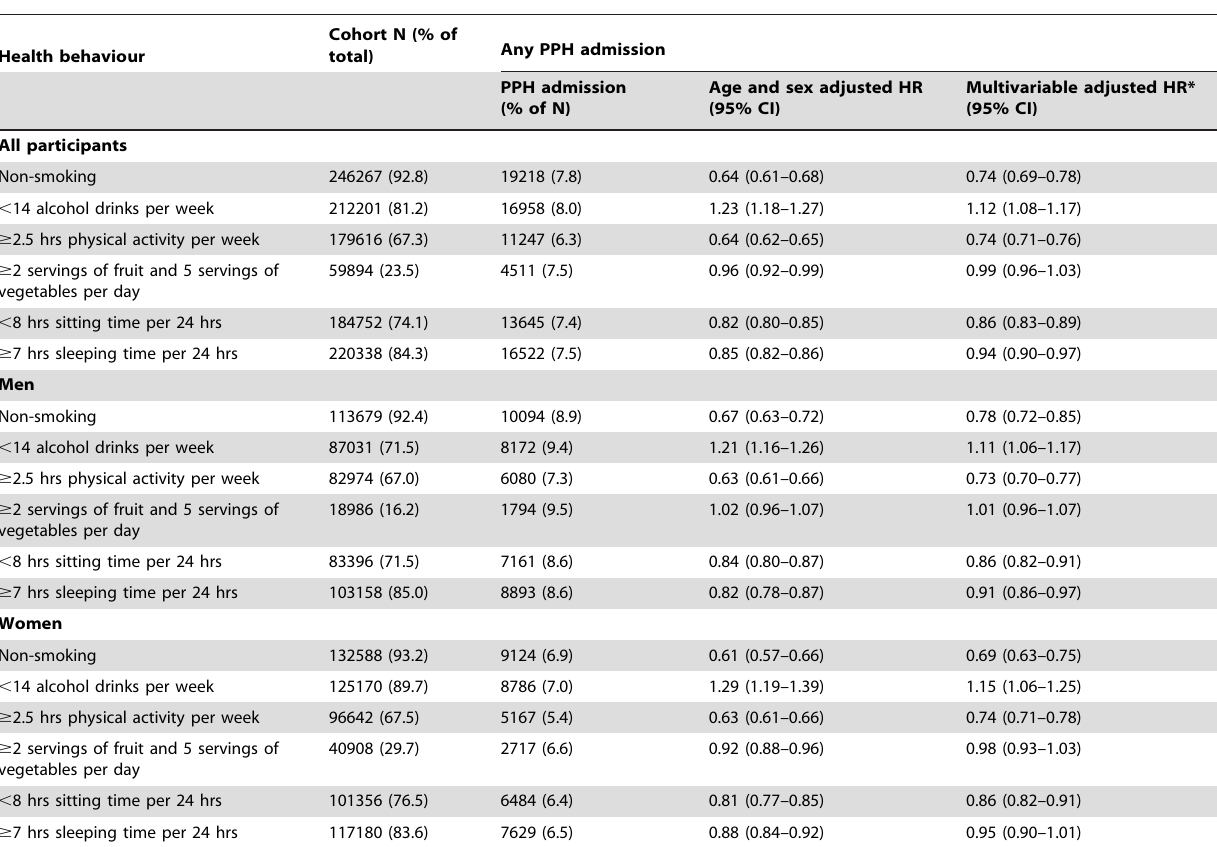
Table 2. Risk of potentially preventable hospitalisation (PPH) for individual health